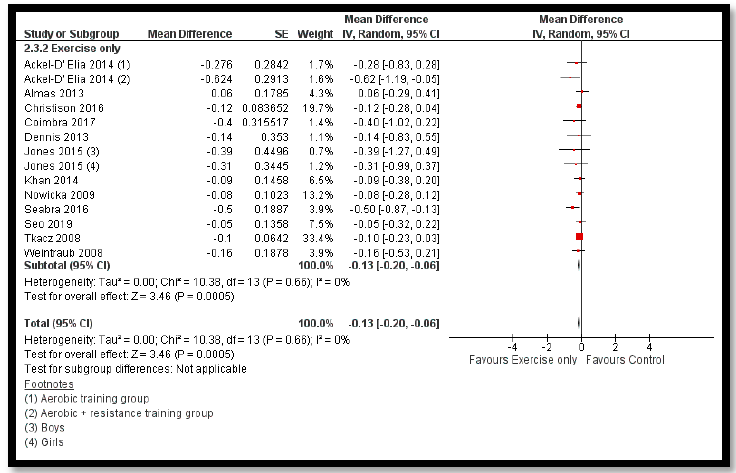
Figure 8. Forest plot for the effect of exercise only interventions for obesity management on body mass index (BMI) z -score .